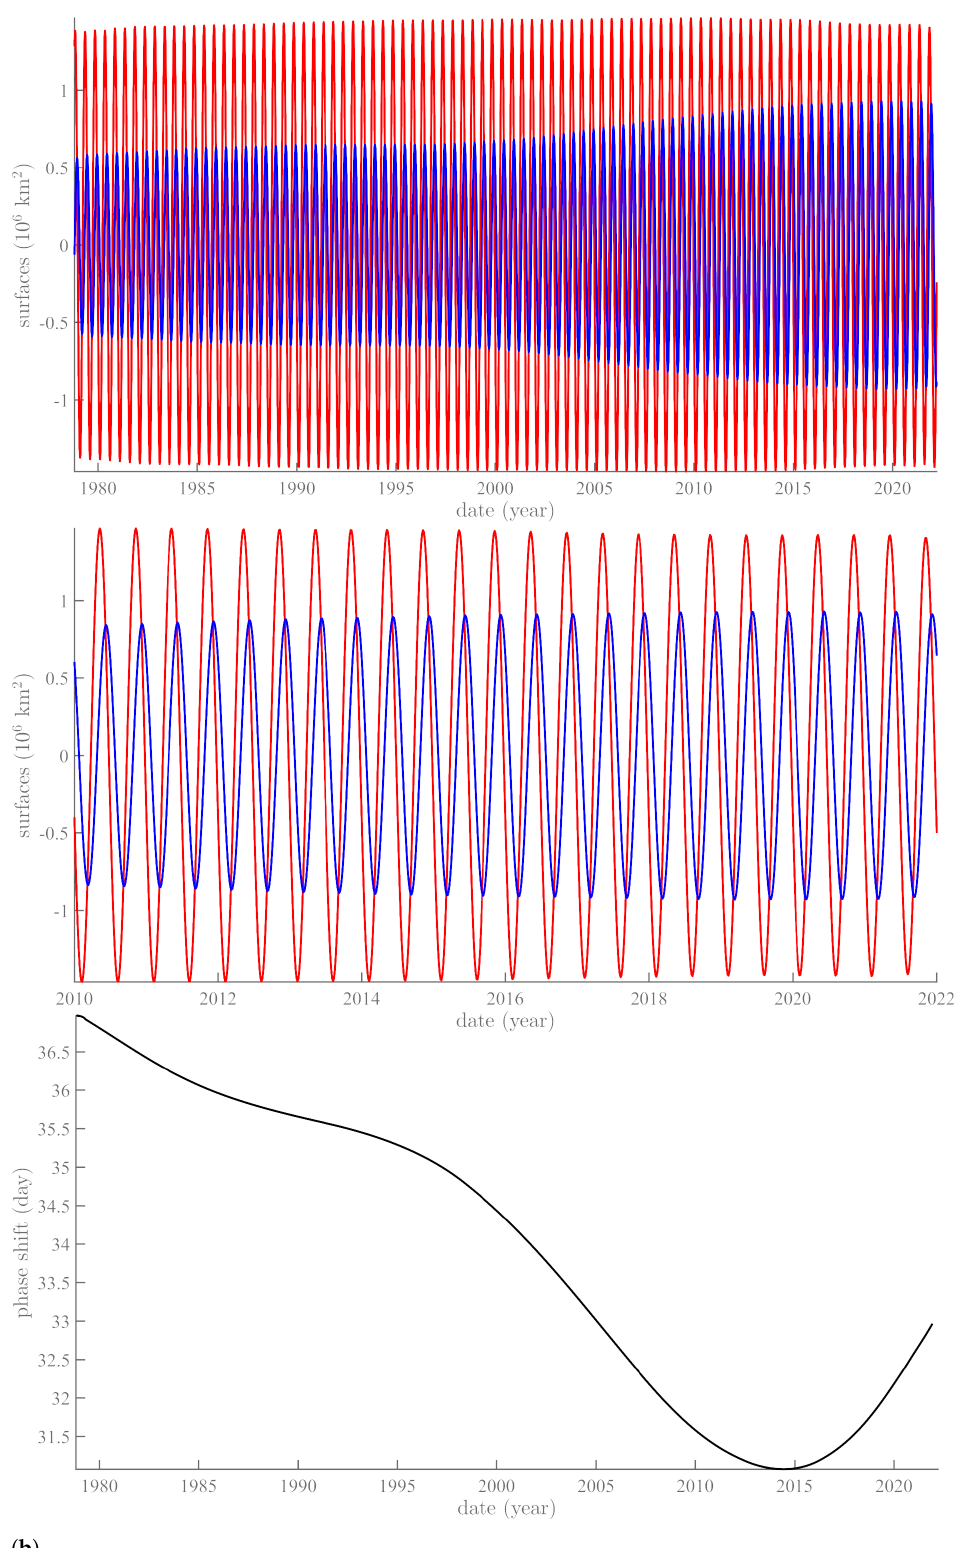
Figure 2. Annual and semi-annual components extracted from SHSI (red) and NHSI (blue): ( a ) SSA annual component of SHSI (red) and NHSI (blue) from 1978 to 2022 ( top ) and their phase difference ( bottom , in days); ( b ) SSA semi-annual component of SHSI (red) and NHSI (blue) from 1978 to 2022 ( top ), an enlargement of the period from 2010 to 2022 ( middle ), and their phase difference ( bottom , in